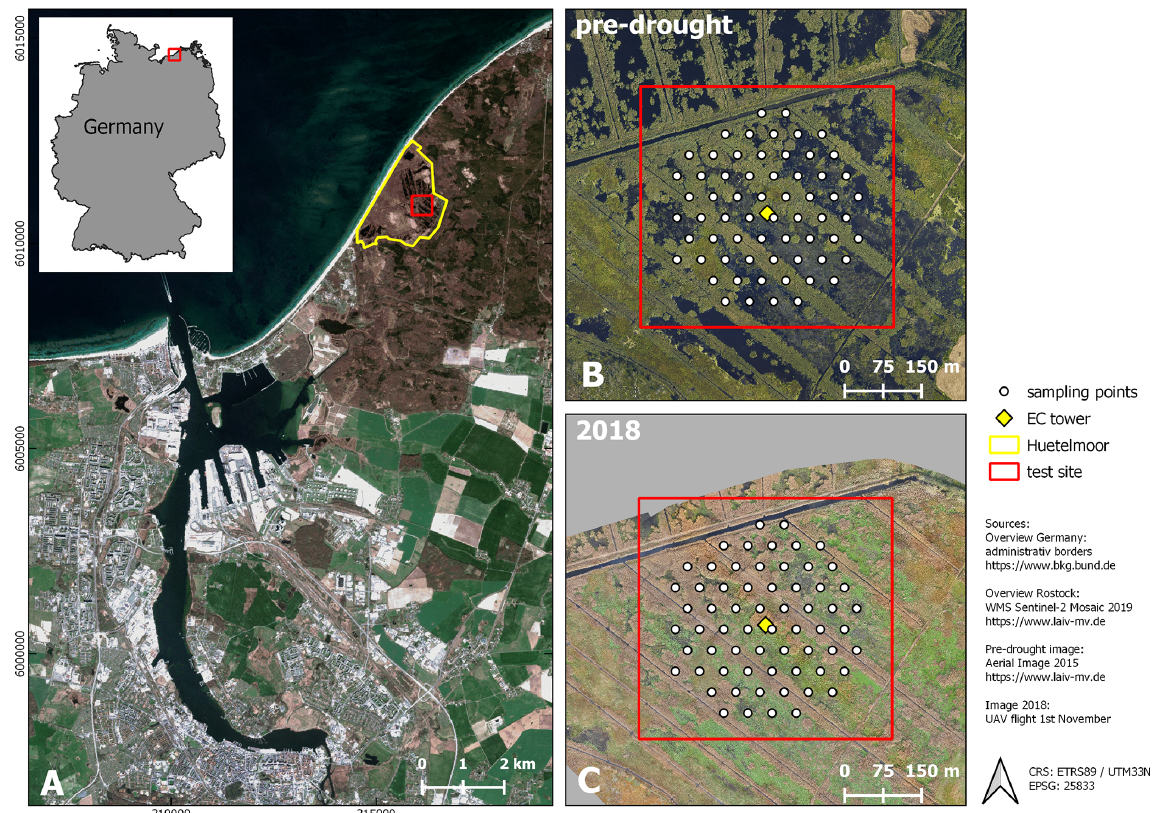
Figure 1. Study site. (A) Location (city of Rostock). (B) August 2015 and (C) November 2018: aerial photograph with vegetation survey grid. From 2010 to 2017 (pre-drought), the fen was almost permanently inundated. At that time, the canopy consisted of a patchy mosaic of open-water and vegetated areas. During the drought in 2018, the site fell completely dry, except for the former drainage